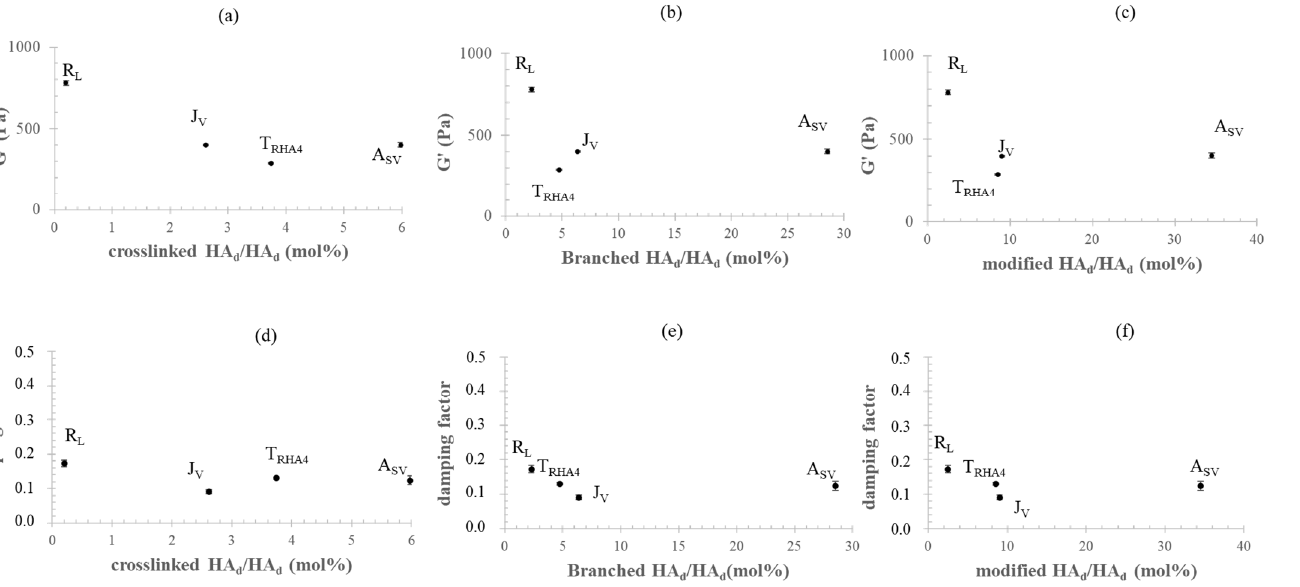
Figure 3. G ′ and damping factor for the commercial gels as a function of the HA chemical modification parameters. G ′ ( a – c ) and damping factor ( d – f ) values as a function of the amounts of crosslinked, branched, and modified HA d (mol%).